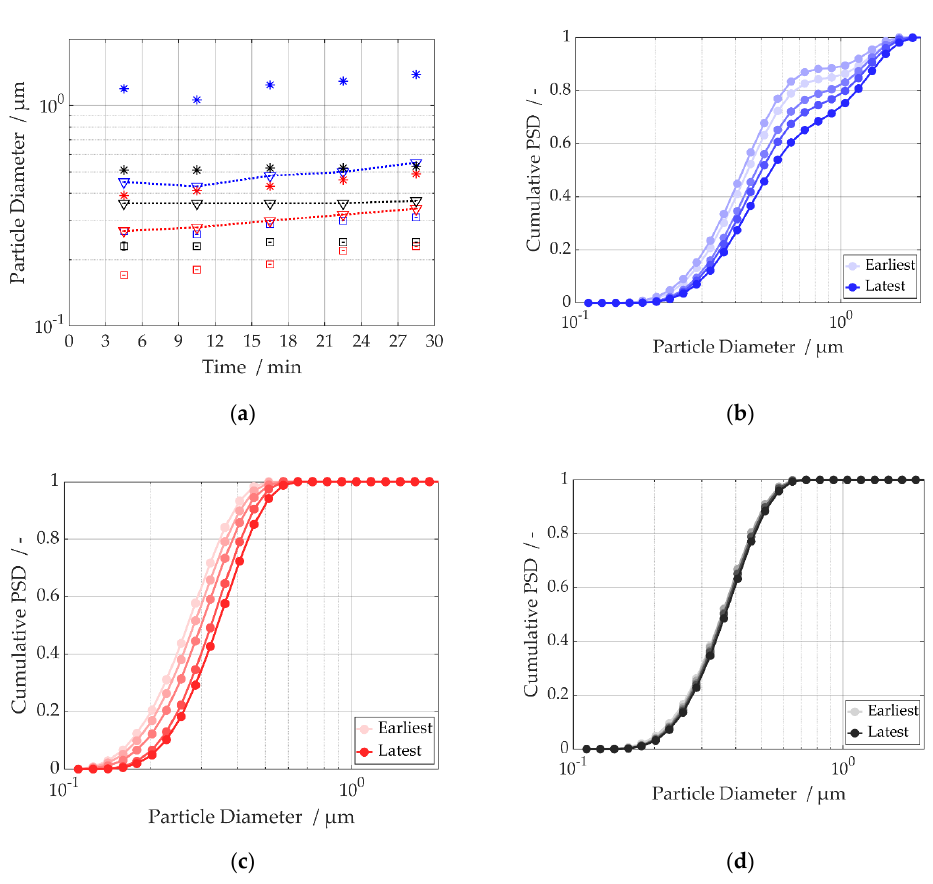
Figure7. Centrateparticlesizedistributionsforthethreecasesovertime. Blue: 20,000rpm; Red:40,000rpm; Black: Increasing rotational speed. ( a ) Characteristic particle sizes, squares: x 10 ; triangles: x 50 with dashed lines as guides to the eye; stars: x 90 . ( b – d ) Detailed particle size distributions for the three cases over time; light color: Earliest measurement; darkening shade with progressing time until darkest color: Latest